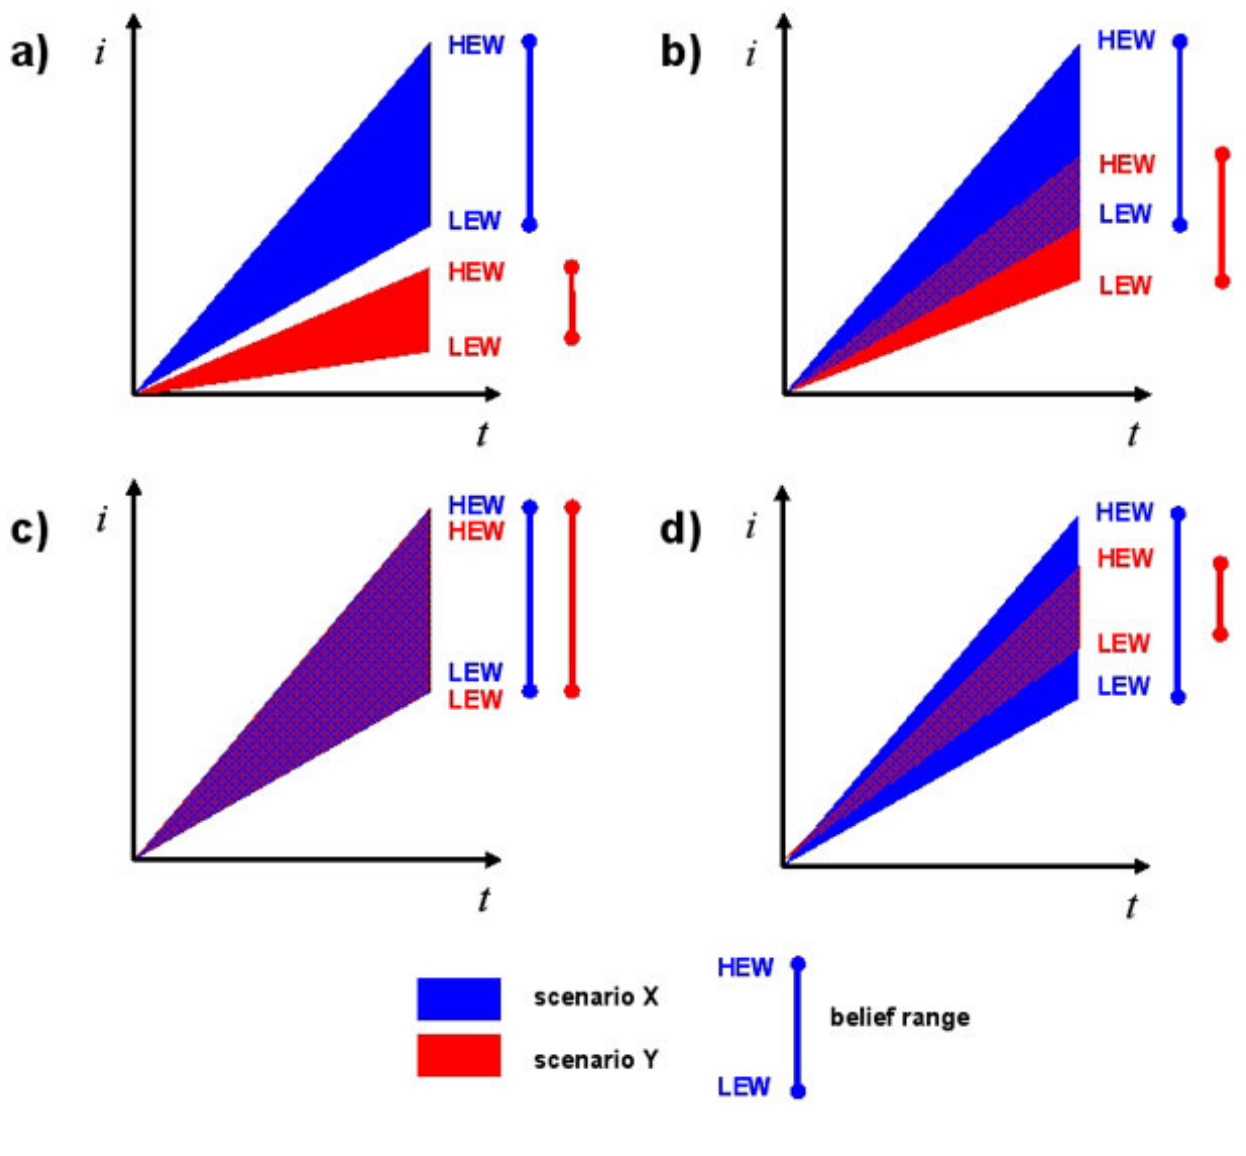
Fig. 2. The difference between high-expectation world (HEW) and low-expectation world (LEW) scenario outcomes for a given indicator, i, define the belief range. Conceptual graphs illustrate possible belief ranges for two alternative scenarios X and Y. Although belief ranges do not necessarily overlap (a), partial (b) or complete (c,d) overlap are